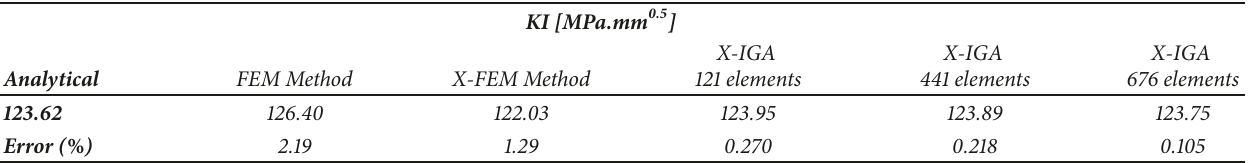
Table 2: Comparison of the KI factors between the proposed method of X-IGA and the analytical, FEM, and X-FEM methods for the case of a crack with a = 3 mm.